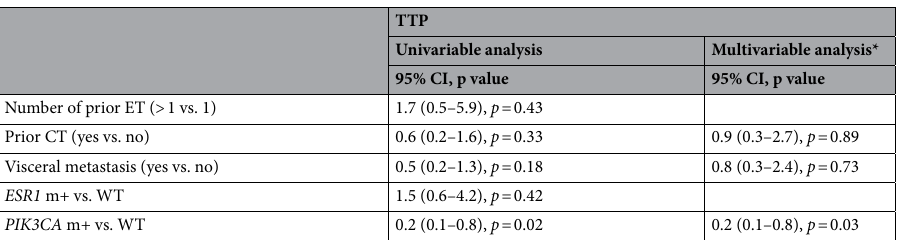
TTP Univariable analysis Multivariable analysis* 95% CI, p value 95% CI, p value